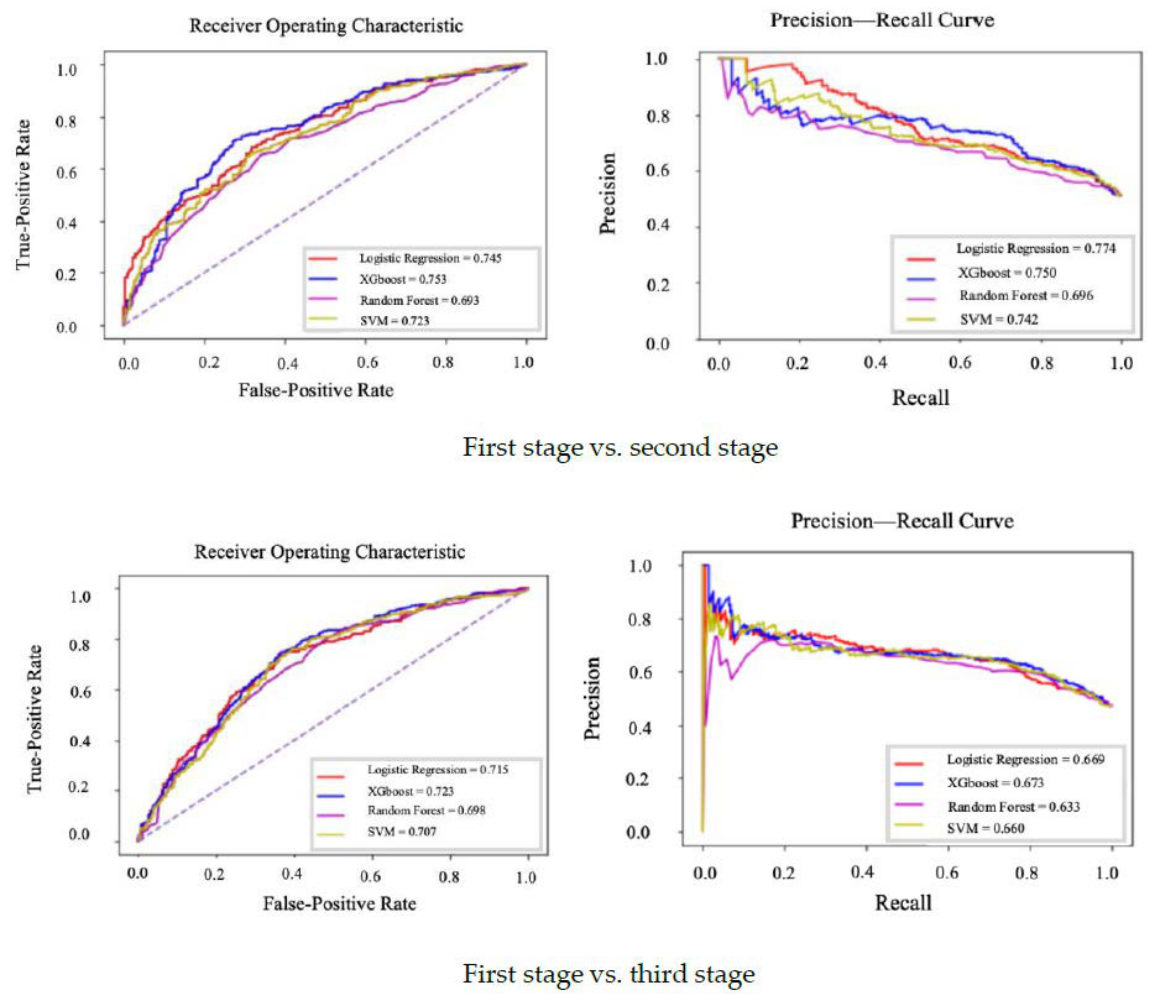
Figure 4. ROC and PRC curves for machine learning models with non-concurrence designs. The differences between the models were more distinct when using baseline features to predict osteopenia during the second stage than when using the baseline features to predict osteopenia during the third stage. The performances of the models for predicting osteopenia occurrence during the second stage according to baseline features are shown in Table 3. Table 3. Model predictions of osteopenia in the second stage (2009–2011) using concurrent and non-concurrent features.